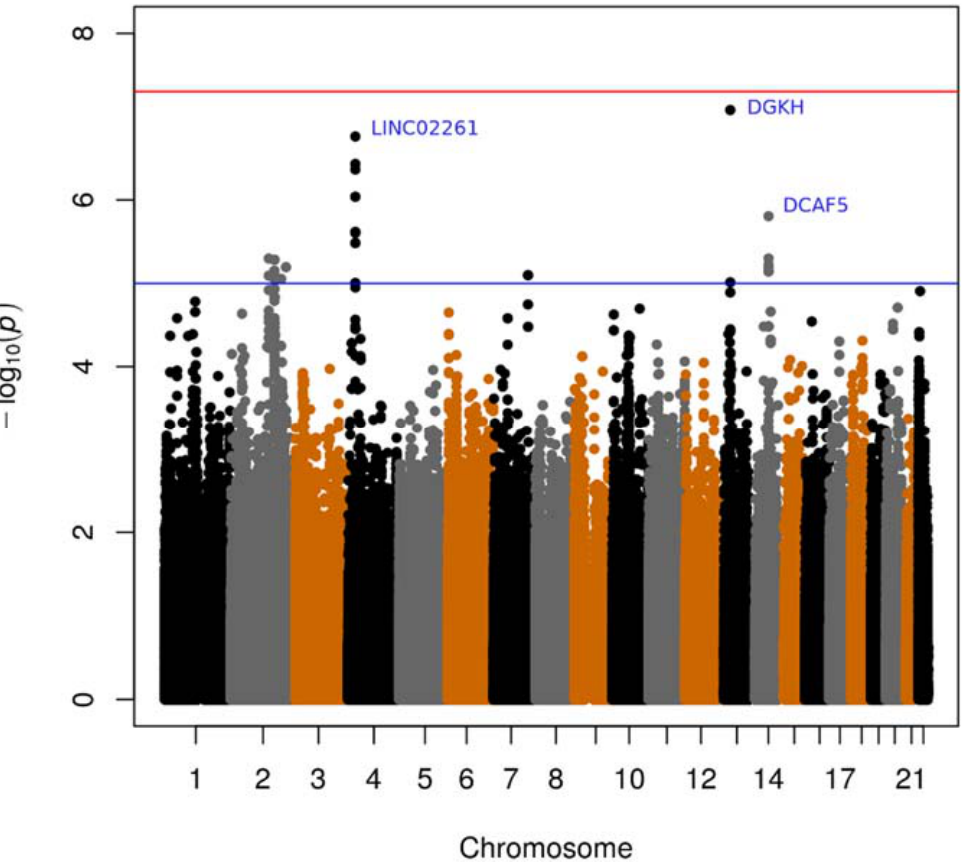
Figure 1. Manhattan plot of the genome-wide association study (GWAS). Manhattan plot illustrating the associations of NPY-LA with all the SNPs from the three sub-cohorts. Abbreviations: NPY-LA, Autoantibodies to neuropeptide Y; SNPs, single nucleotide polymorphisms. Blue line: suggestive line ( p -value < − log 10 (1 × 10 − 5 )); red line: genome-wide line ( p -value < − log 10 (5 × 10 − 8 )). The black, grey and orange dots represents SNPs, and these three colors alternate for the chromosomes. Several SNPs mapped to the intergenic region on chromosome 4 upstream of LINC02261